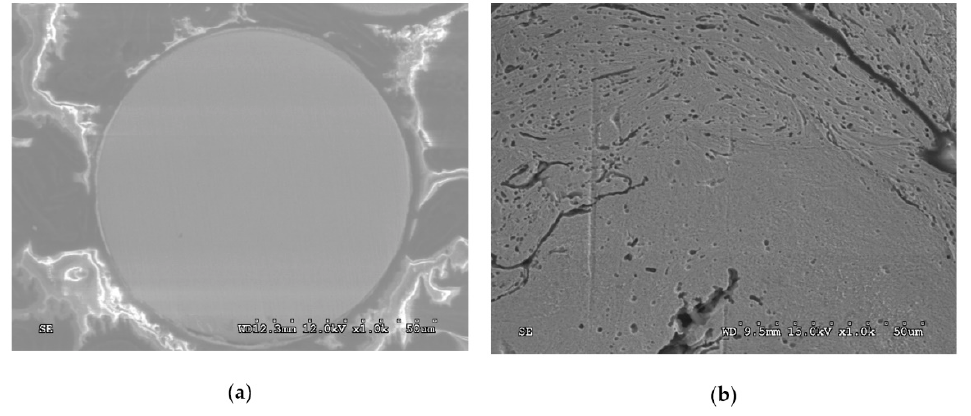
Figure 1. ( a ) Starting powder particle after atomization; ( b ) Powder particle after milling for 50 h (BPR 2:1).